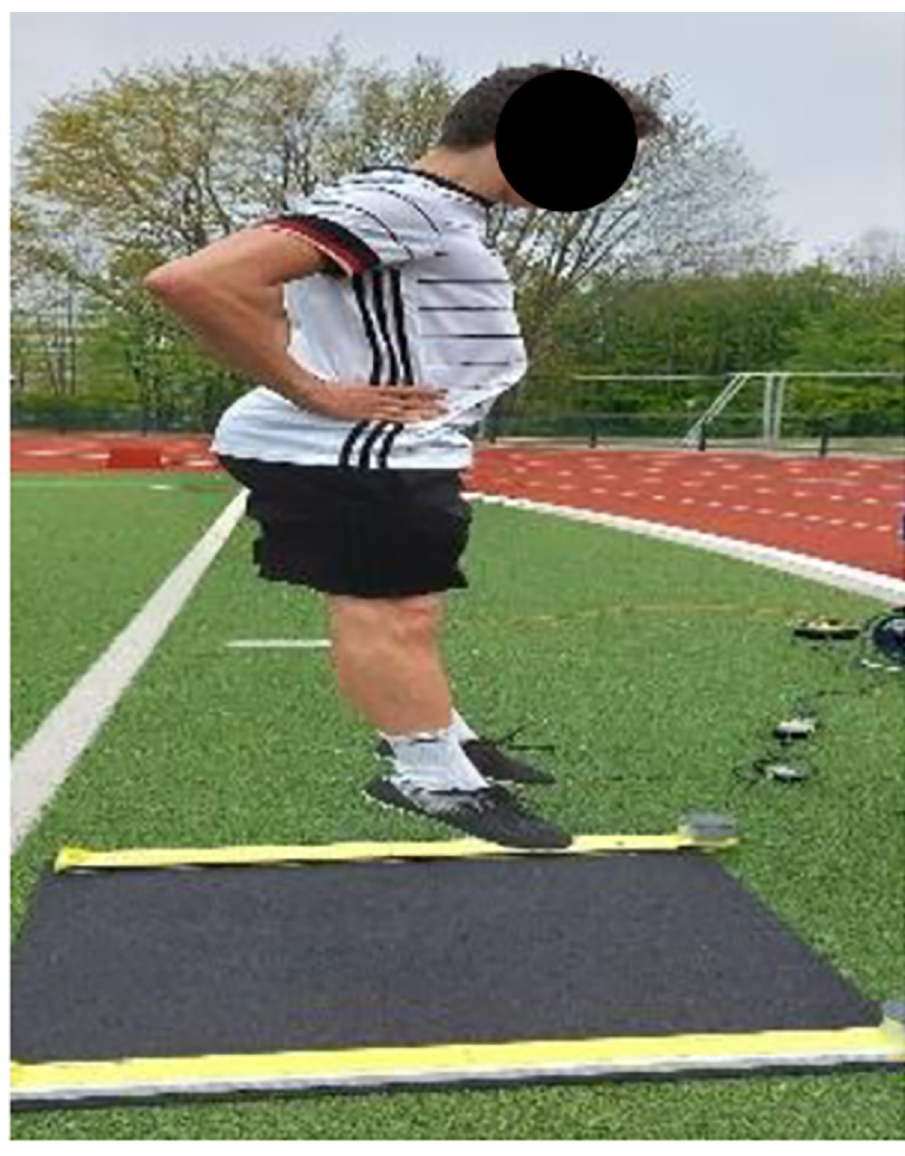
Fig 2. Countermovement jump